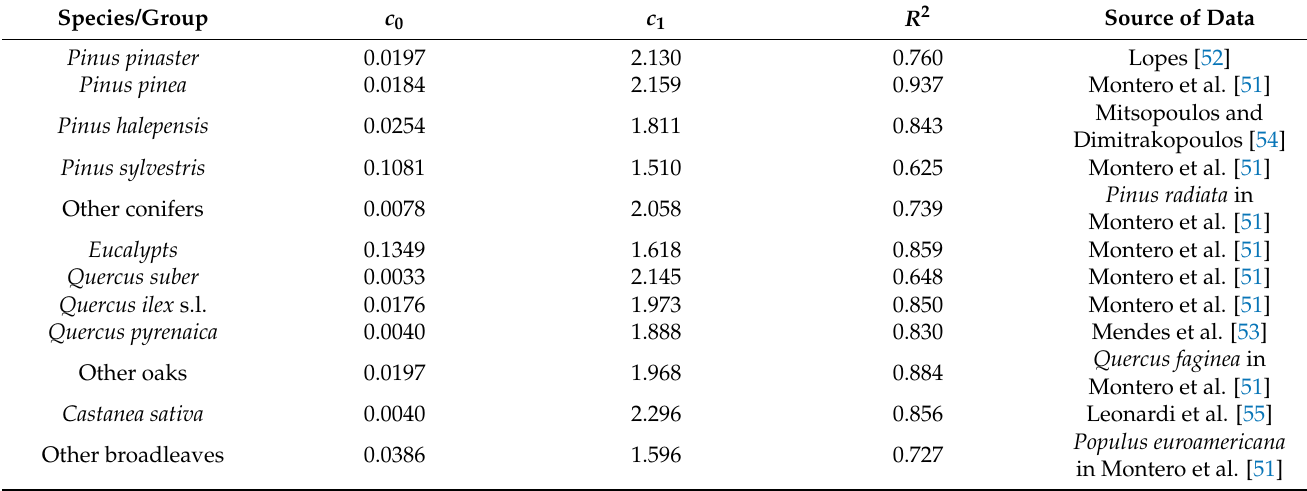
Table 4. Parameter estimates and coefficients of determination for the tree species or groups of species, obtained fitting Equation (16), relating Crown Leaf Biomass (CLB) and Diameter at Breast Height (DBH).